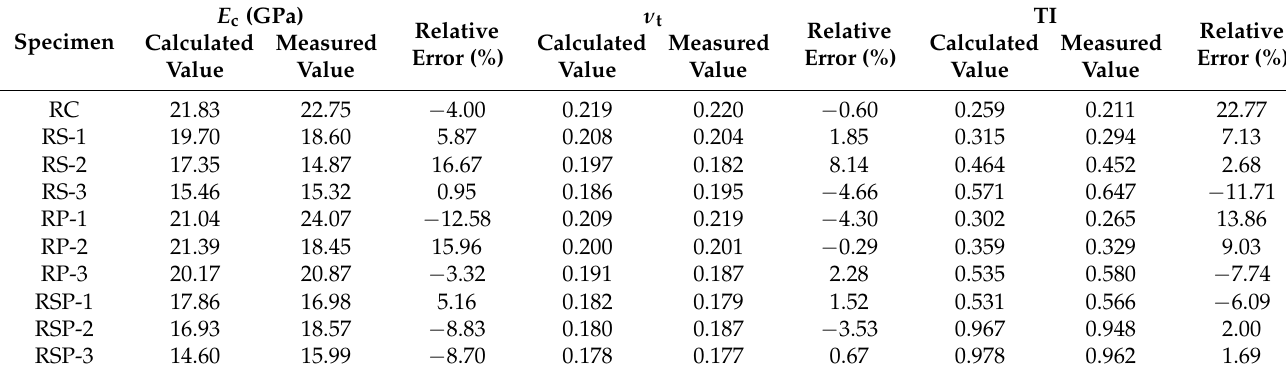
Table 5. The relative error between the calculated value and the measured